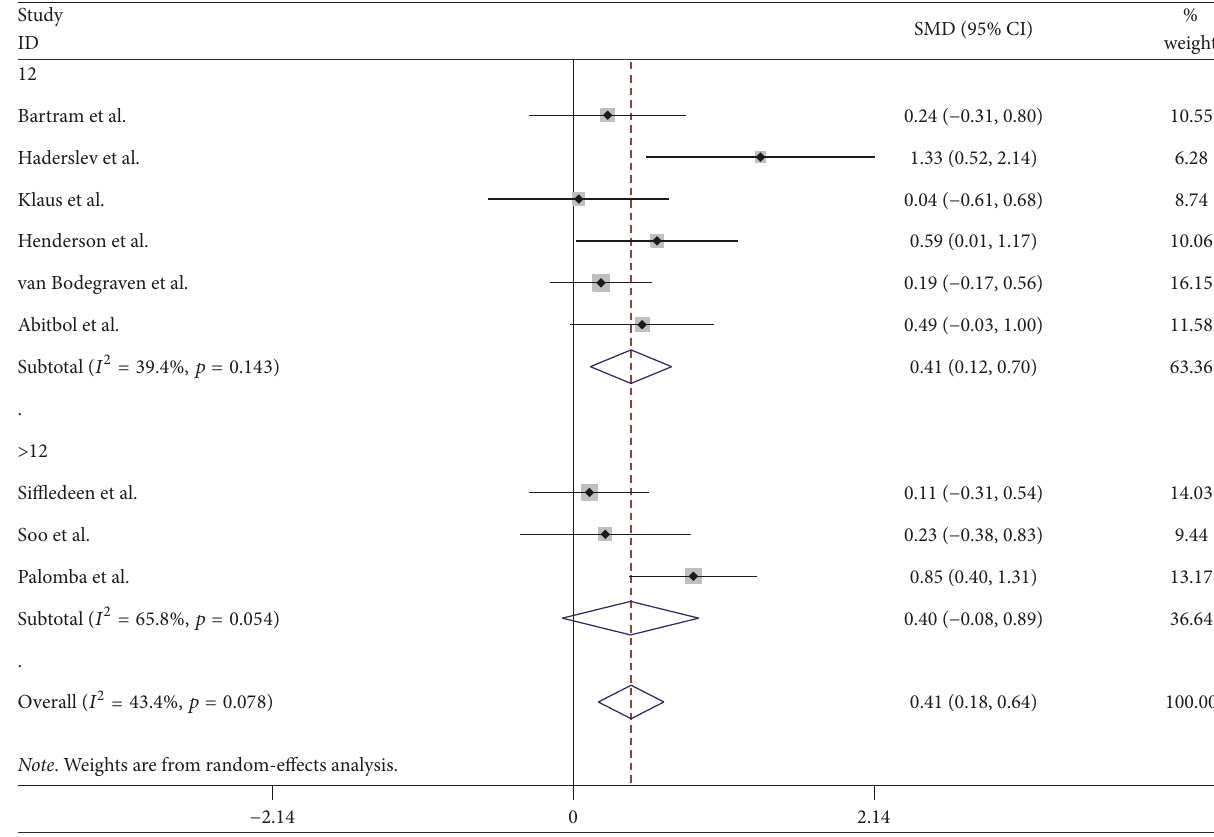
found between the bisphosphonate and control groups (OR